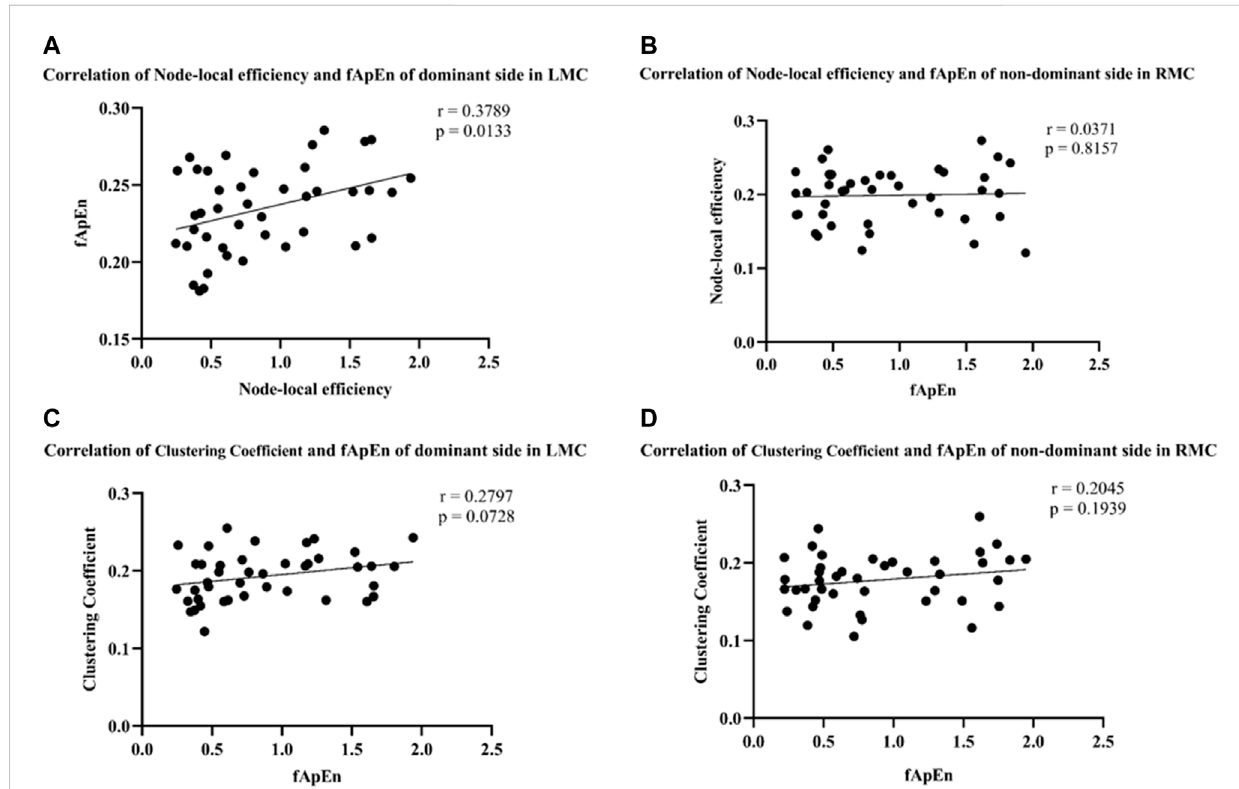
FIGURE 9 (A,B) Correlation of node-local ef fi ciency and fApEn of the dominant side in LMC (r = 0.3789, p = 0.0133) and the non-dominant side in RMC (r = 0.0371, p = 0.8157). (C,D) Correlation ofclustering coef fi cientand fApEnofthedominant sideinLMC(r=0.2797, p =0.0728)andthenon-dominantside in RMC (r = 0.2045, p =